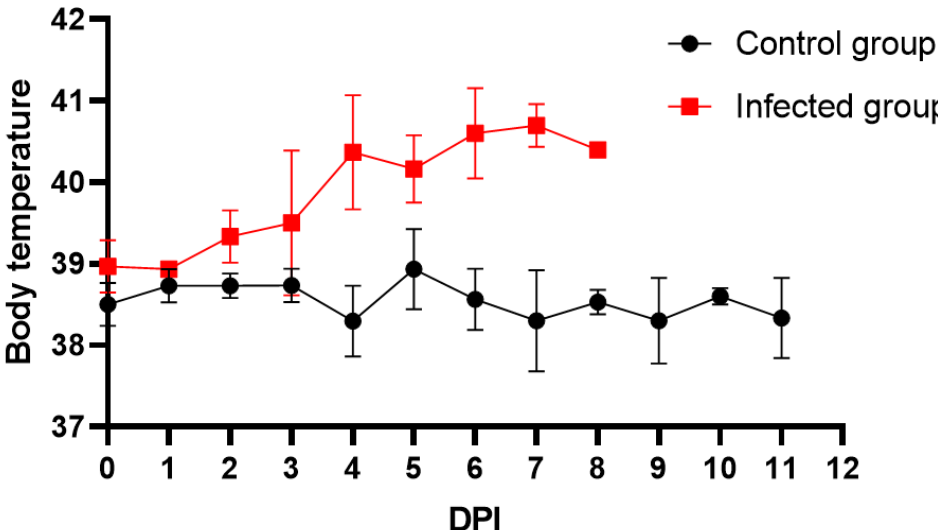
Figure 1. Body temperature detection. Six 4-week-old pigs were randomly divided into two groups and then infected with 10 2 HAD 50 of the ASFV CADC_HN09 strain and PBS, respectively. All infected pigs presented with a rise in body temperature (above 40.5 °C) from day 3 dpi, and 2 piglets died at 7 dpi, and all died at 8 dpi.